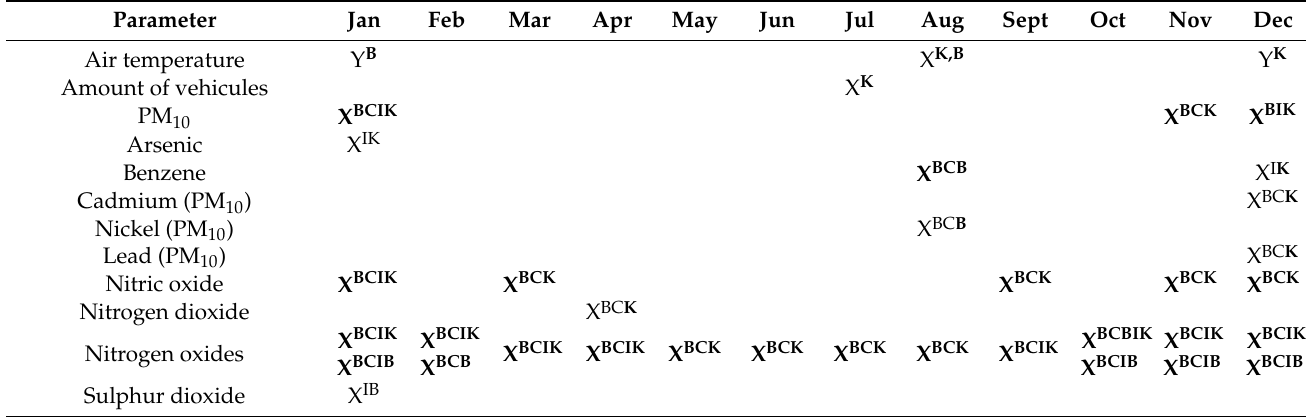
Table 6. List of the highest air pollution